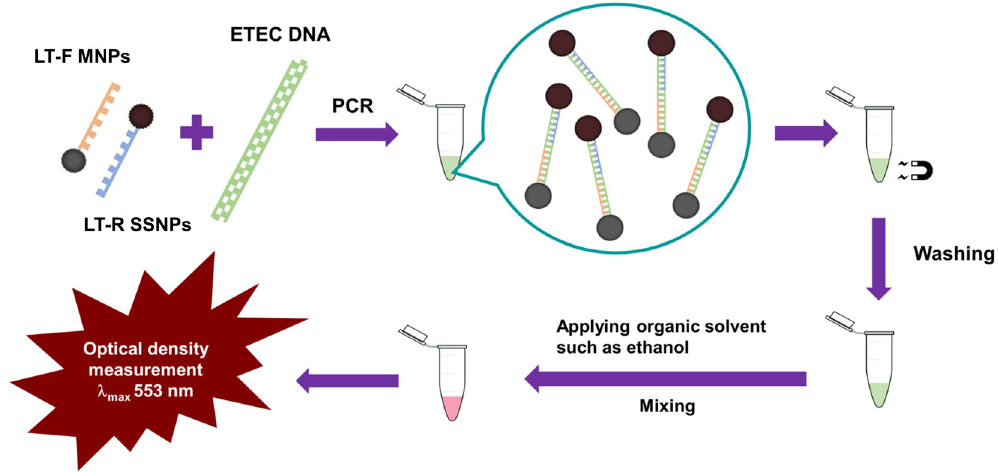
Figure 1. Schematic representation of the solvent-sensitive nanoparticle (SSNP)-enhanced PCR assay for the detection of enterotoxigenic Escherichia coli